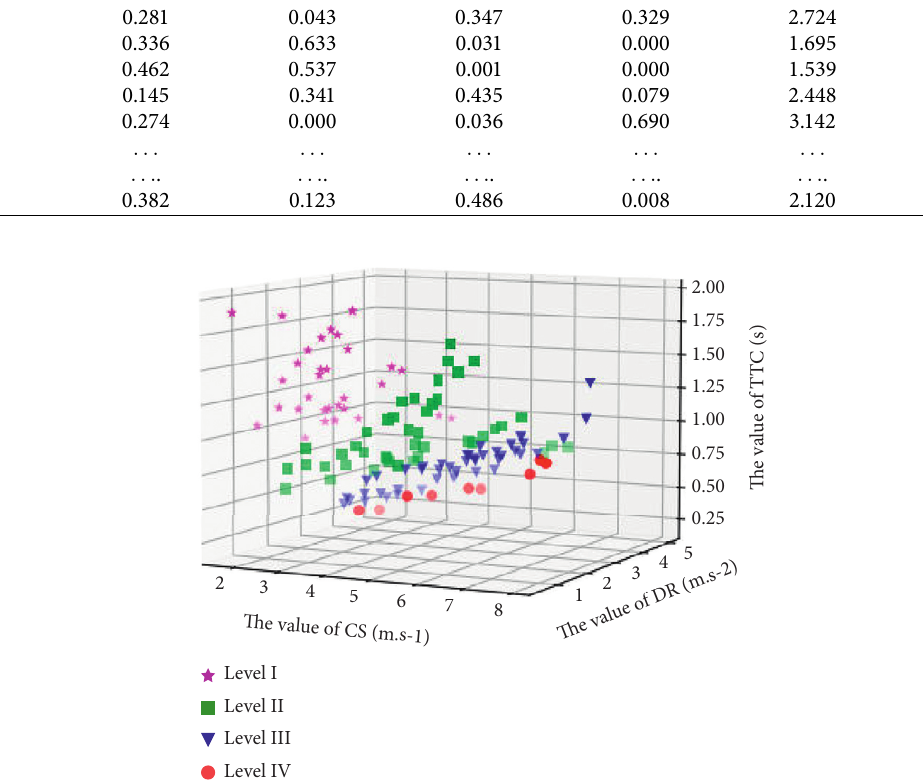
Figure 10: Distribution of safety levels of conflict points at the